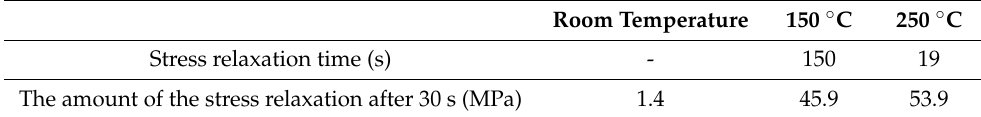
Figure 12. The residual stress according to the holding time at the pre-strain of ε 75 ( ε = 0.012) with different temperatures. Table 4. The amount of the stress relaxation and the stress relaxation time.